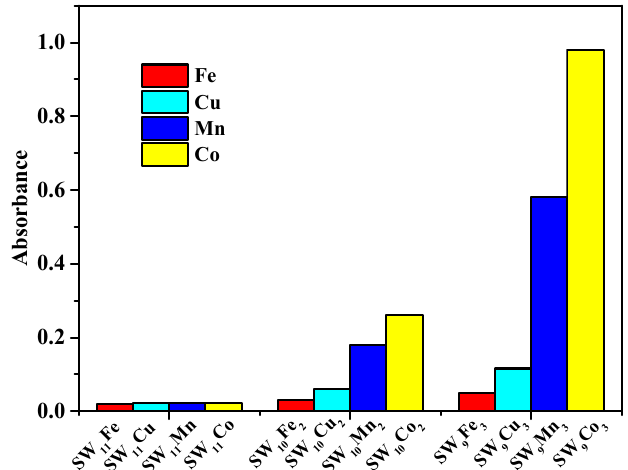
Figure 2. Comparison of SiW 11 M, SiW 10 M 2 and SiW 9 M 3 catalysts for the detection of DA at 475 nm in aqueous solutions with 60 µL H 2 O 2 , 120 µL DA, and 80 µL of catalyst, with a reaction time of 10 min.